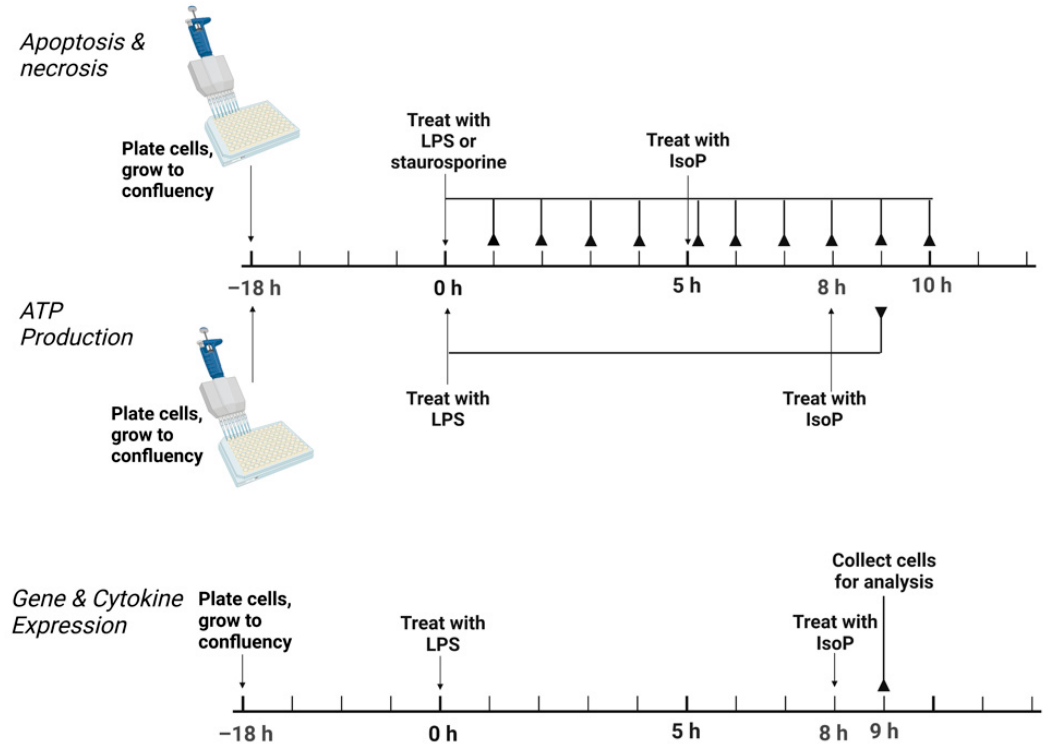
Figure 1. Experimental design to test the effect of 15F 2t isoprostane on RAW 264.7 macrophage polarization. For apoptosis, necrosis, and ATP production, the solid lines ending in reverse arrowheads represent timepoints when plates were read on a Tecan Infinite 200 Pro. For gene and cytokine expression, the solid line ending in a reverse arrowhead represents the point at which cells were collected for further analysis. LPS—lipopolysaccharide; IsoP—isoprostane; h—hour.